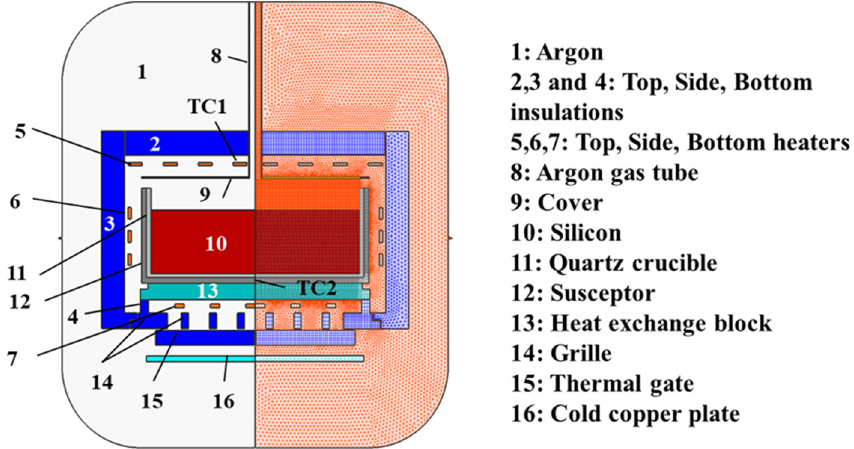
Figure 1. Structure and configuration of ALD-G7 furnace ( left ) and computation grids ( right ).